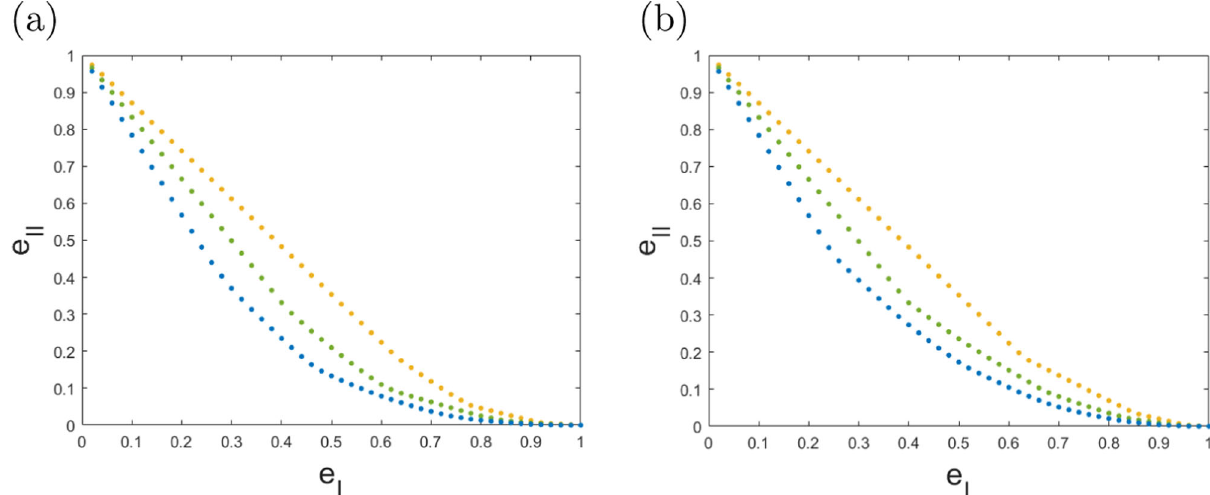
Fig. 4 Maxwell demon games played for various numbers of rounds. The referee has access to measurement strategies from the sets M 2 ( a ) and M 3 ( b ) within each round. The choice of the overall POVM implemented in each round will, in either case, depend on all inputs and outputs of previous rounds. The curves display the optimal trade-off between type-I and type-II error, (e I , e II ), for n = 1 (yellow), n = 2 (green) and n = 3 (blue) for E ¼ f ϕ